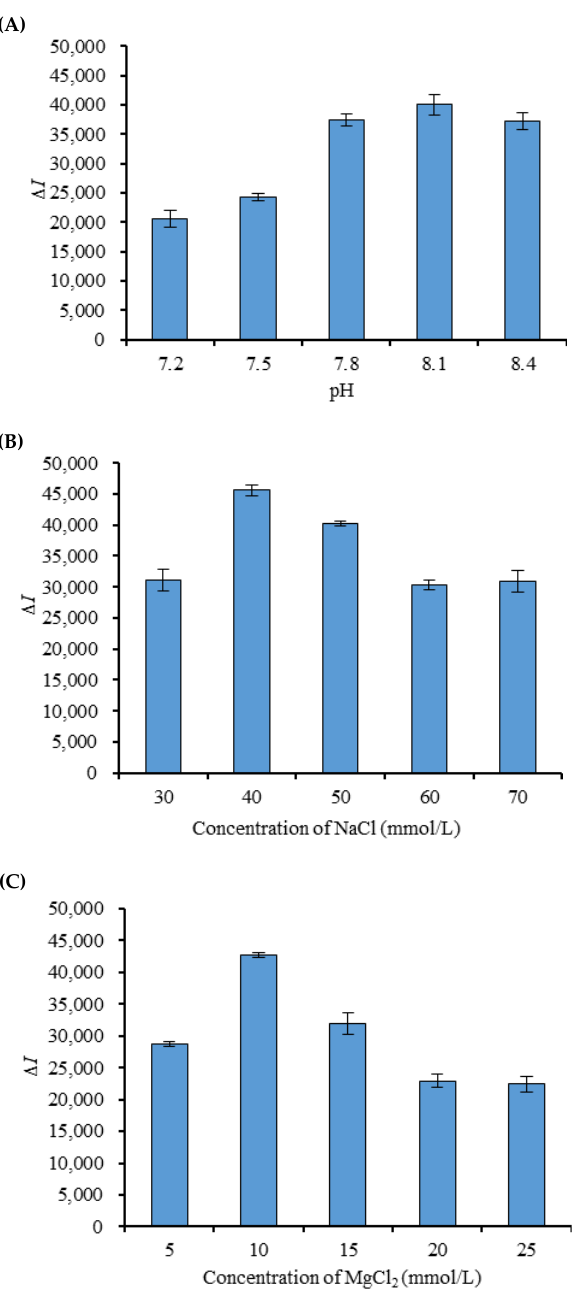
Figure 5. The effects of pH ( A ), concentrations of NaCl ( B ) and concentrations of MgCl 2 ( C ) on the fluorescence intensity.